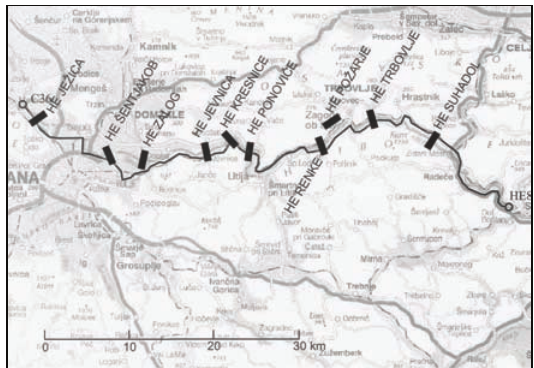
Fig. 1. The levelling line and the planned sites of the new HPPs